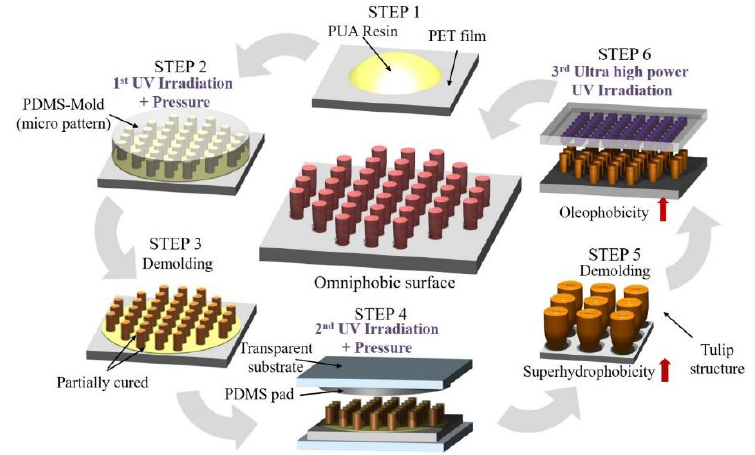
Figure 1. Flow diagram of designed tulip-shaped pattern imprinting process.